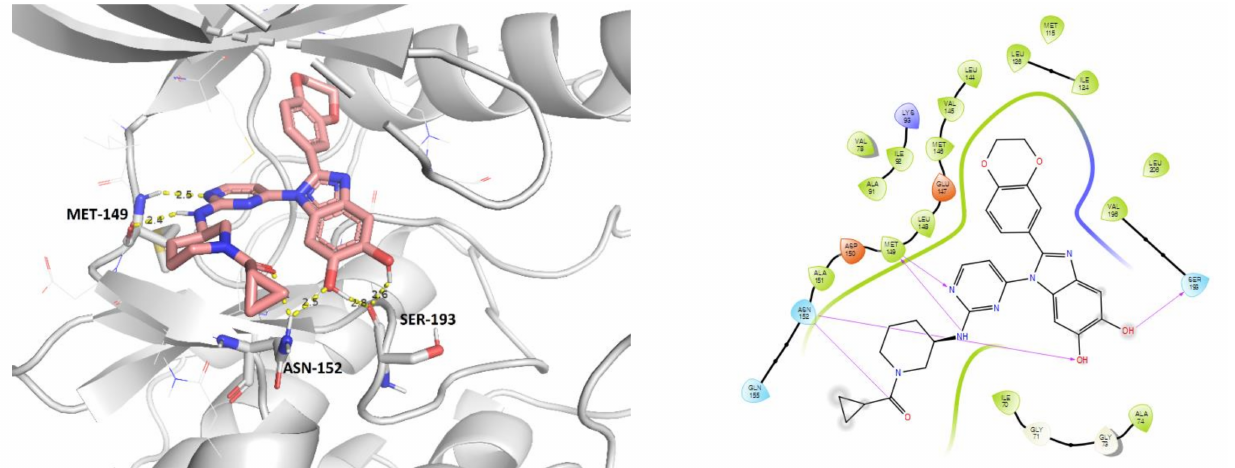
Figure 3. Molecular docking model of compound 35b bound with